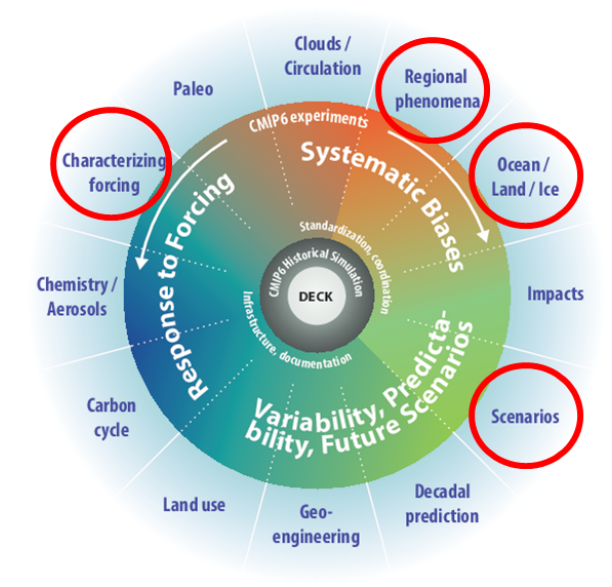
Figure 3. Embedding of LS3MIP within CMIP6. Adapted from Eyring et al. (2015).